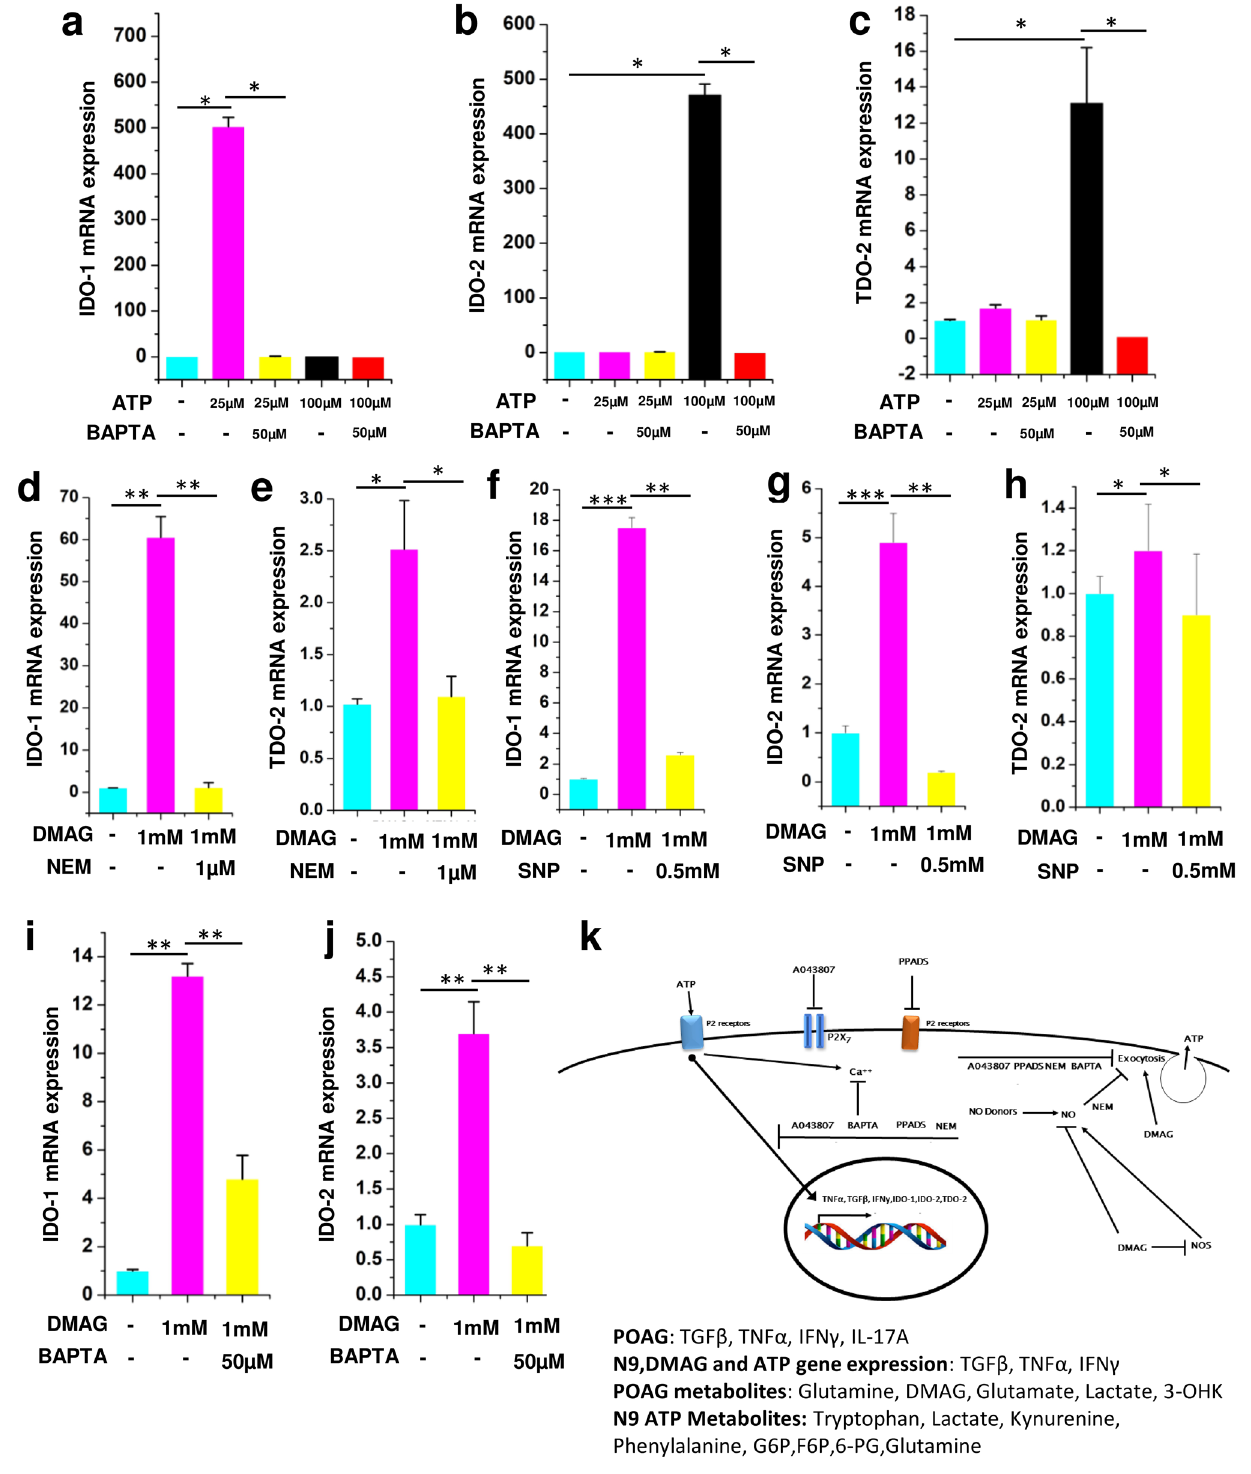
Figure 6. ATP and DMAG induced tryptophan pathway gene expression and their modulation by BAPTA, NEM and SNP respectively. Showing ATP (25 μM or 100 μM) treated N9 cells or those pre-incubated with BAPTA (50 μM) before treating with ATP showing ( a ) IDO-1 ( b ) IDO-2 ( c ) TDO-2. DMAG (1 mM) treated N9 cells with or without pre-incubation with NEM (1 μM) ( d ) IDO-1 ( e ) TDO-2. DMAG (1 mM) treated N9 cells with or without pre-incubation with SNP (0.5 mM) ( f ) IDO-1 ( g ) IDO-2 ( h ) TDO-2. DMAG (1 mM) treated N9 cells with or without pre-incubation with BAPTA (50 μM) ( i ) IDO-1 ( j ) IDO-2. ( k ) Showing overall mechanism. The significance was calculated using Student T-test. *for P < 0.05, ** for P < 0.01, and *** for P < 0.001. For n numbers and the results provided as mean ± SEM, refer to text. Figure 6 k was created using Microsoft office Professional Plus 2016